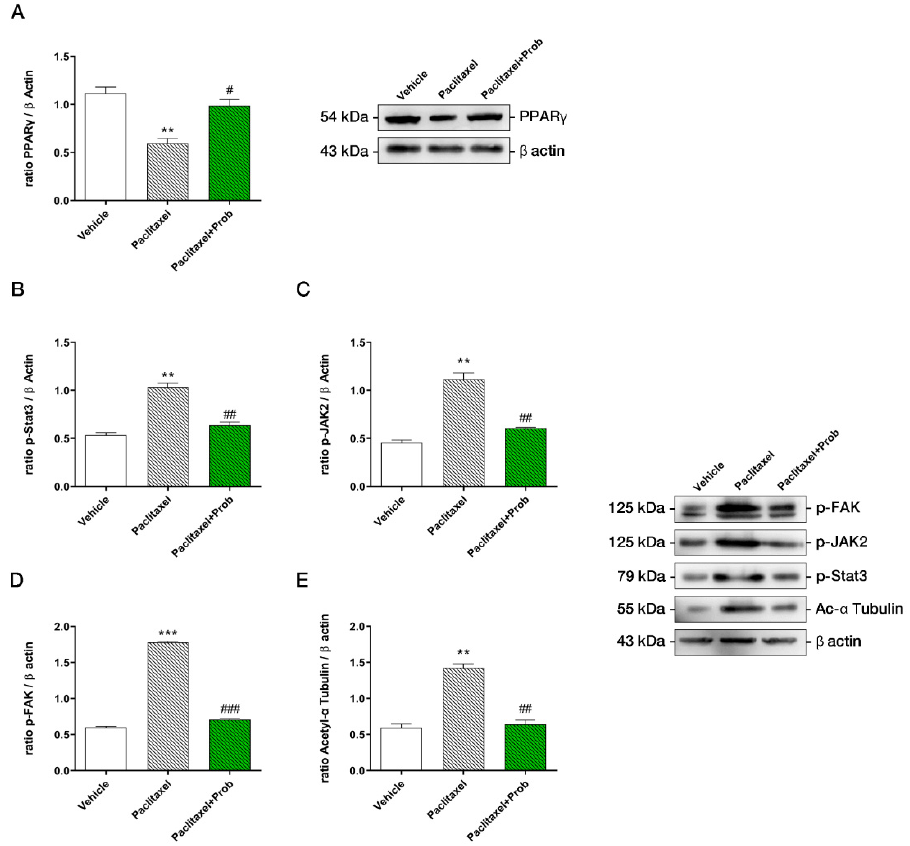
Figure 5. Western blotting analyses for PPAR γ ( A ), p-STAT3 ( B ), p-JAK2 ( C ), p-FAK ( D ), acetyl α -tubulin ( E ) in spinal cords. ***, p < 0.0001; **, p < 0.005; vs vehicle; ###, p < 0.0005; ##, p < 0.005; #, p < 0.05 vs. paclitaxel ( n = 3). A representative figure for each protein is shown.